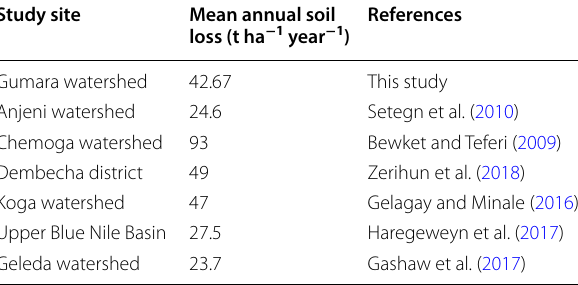
Table 7 Consistency of model estimate with previously published results in the Upper Blue Nile